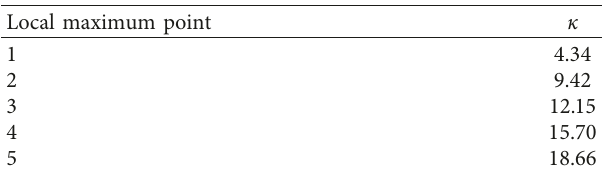
Figure 3: Derivative function of | F b1 ( κ )| with respect to κ . Table 1: Nondimensional speeds corresponding to the extreme points of | F b1 ( κ